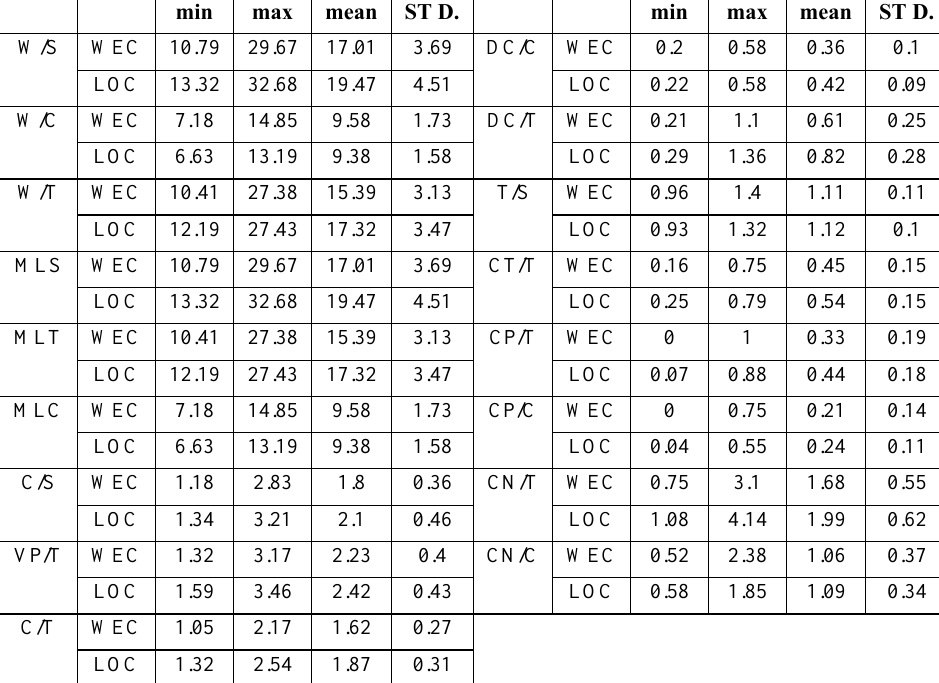
Table 2. Descriptive statistics of the syntactic complexity indices for WECCL / LOCNESS.